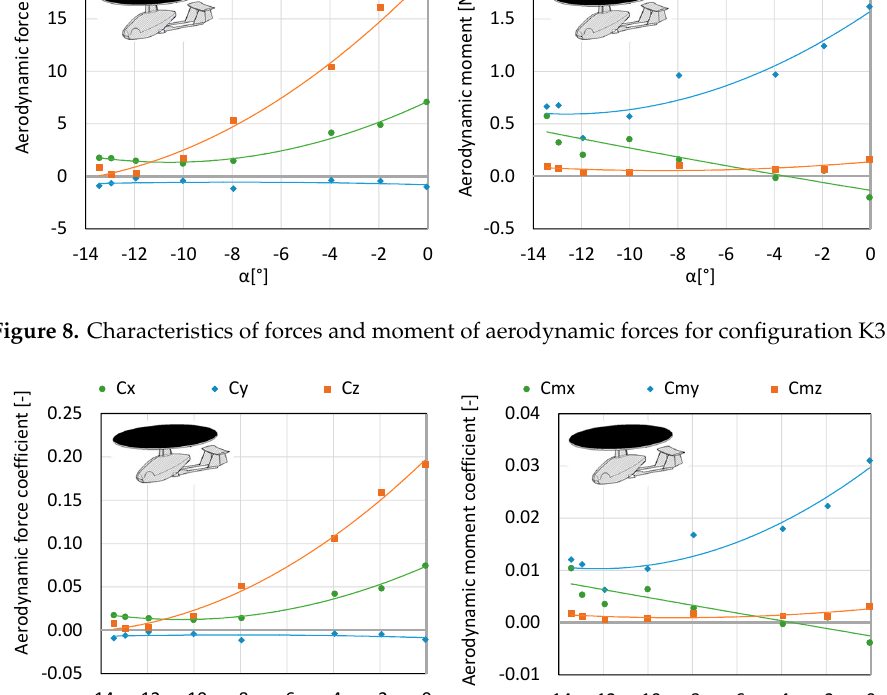
Figure 9. Characteristics of coefficients of forces and moment of aerodynamic forces for configuration K3.